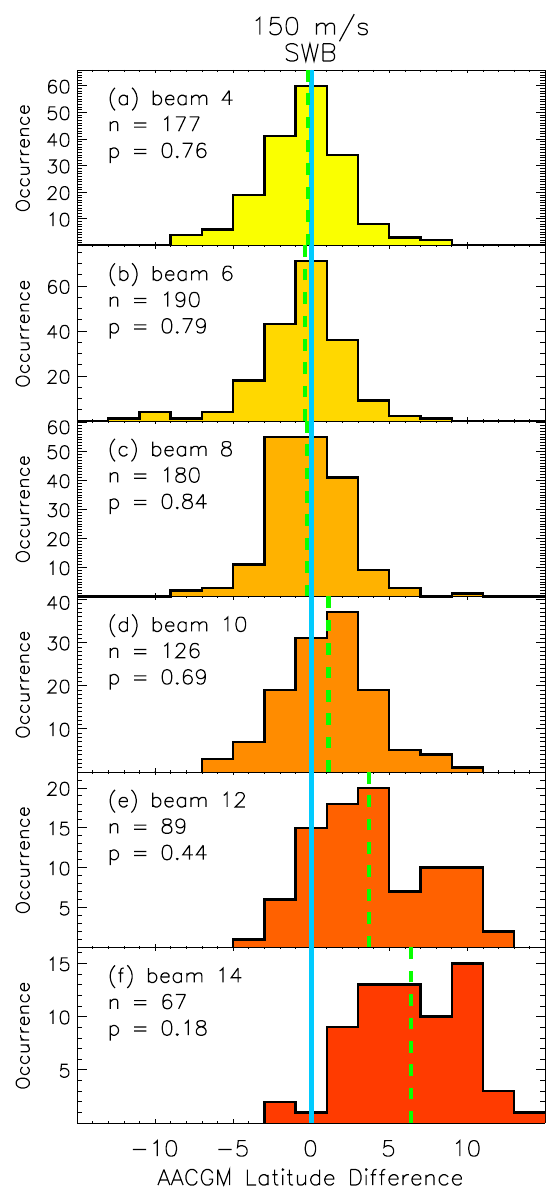
Fig. 2. Occurrence distributions of latitudinal differences between the DMSP OCBs and the 150m/s threshold SWB for a number of different beams from the Goose Bay radar for the 1000–1400 MLT region. The distributions come from (a) beam 4, (b) beam 6, (c) beam 8, (d) beam 10, (e) beam 12, and (f) beam 14. The verti- cal blue line at 0 ◦ latitude difference represents the location of the 150m/s threshold SWB. The vertical green dashed lines represent the median values for each distribution. Also shown are the number of matched pairs that make up the difference distributions for each beam (n) , and the percentage of the difference values that are within 3 ◦ of zero difference (p)